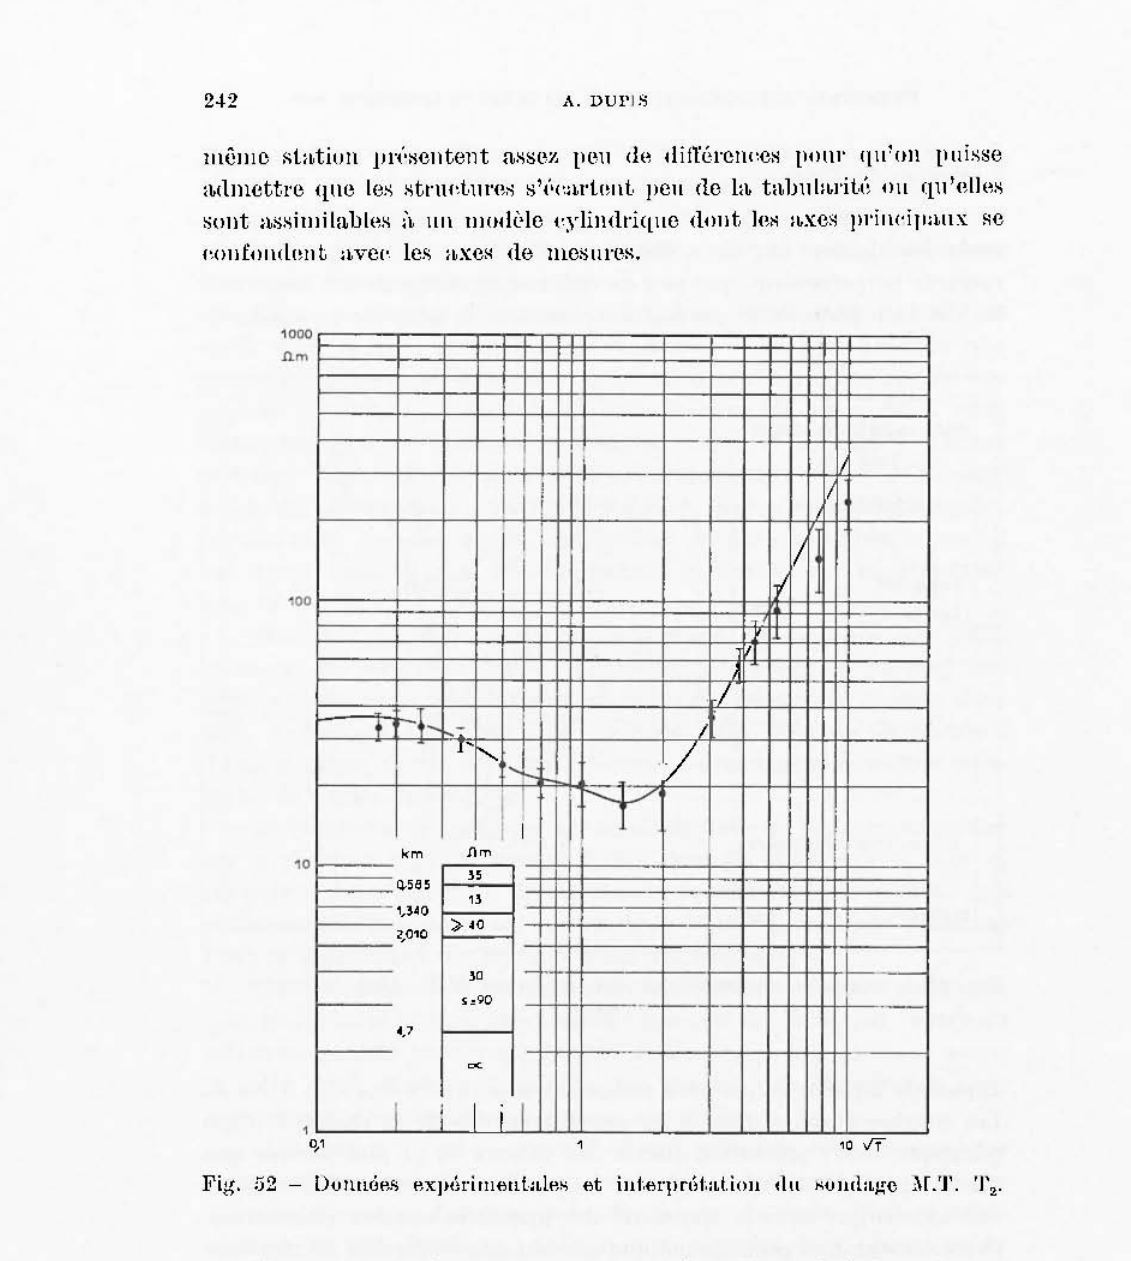
Fig. 52 - [)UlttIOI'"~ expéritlletltale~ et ill1.erprM.at.ioll du J<UlHlagC .\[.'1'.